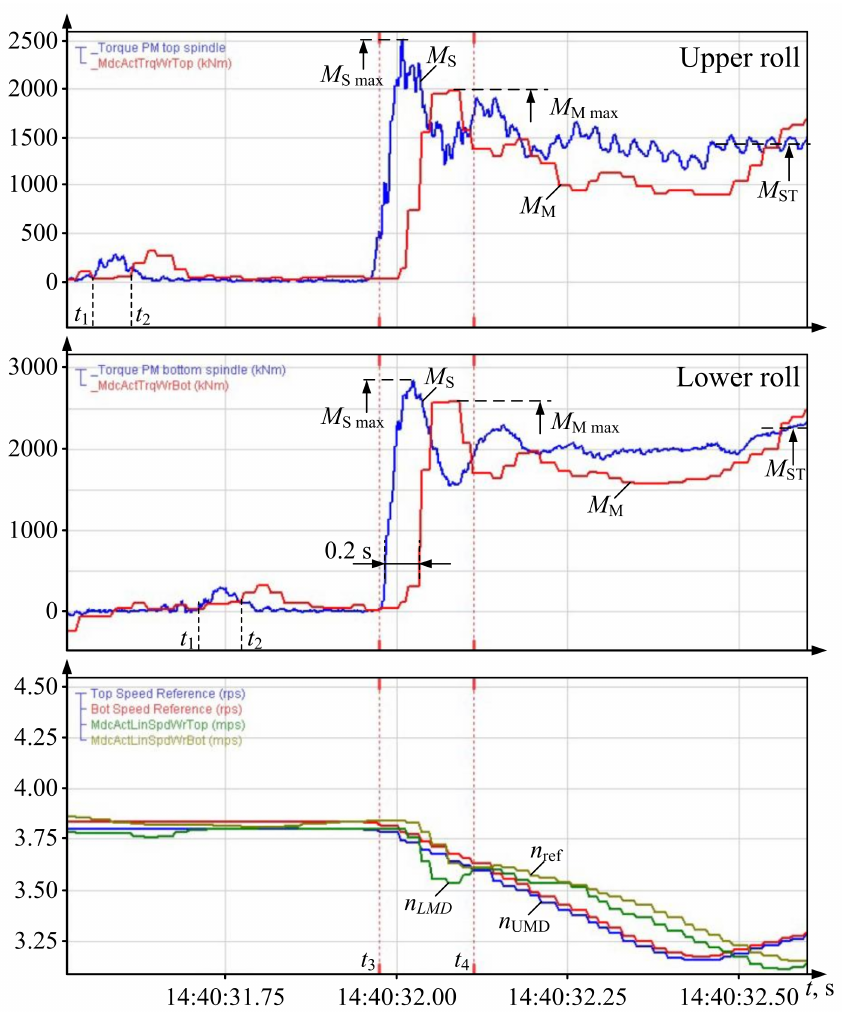
Figure 14. Oscillograms of the UMD and LMD coordinates with different ACS